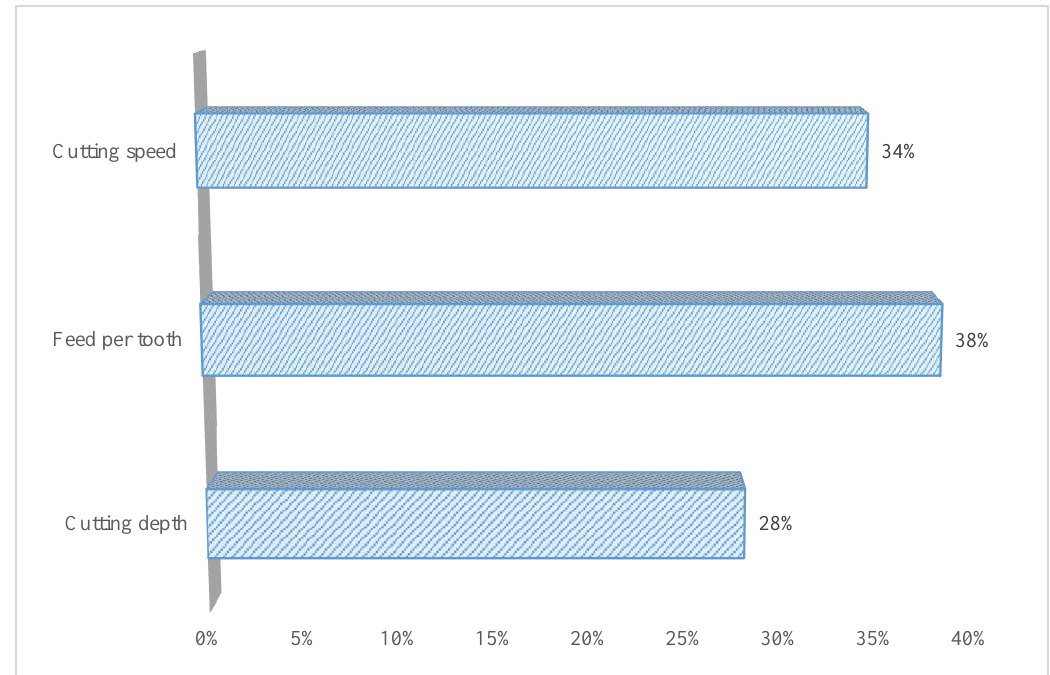
Figure 2. The most studied cutting parameters in the aluminum alloys machining in 2005–2019 period.